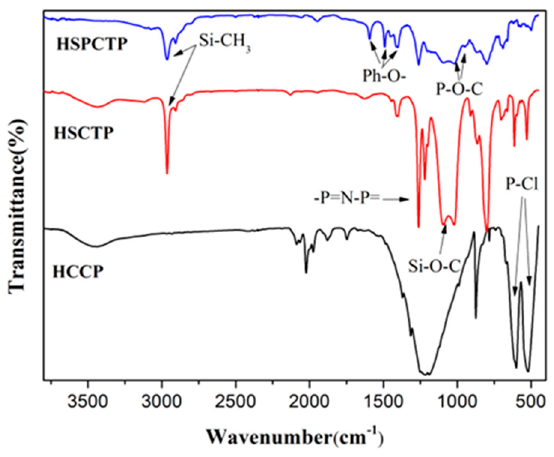
Figure 1. FTIR spectra of HCCP, HSCTP and HSPCTP.